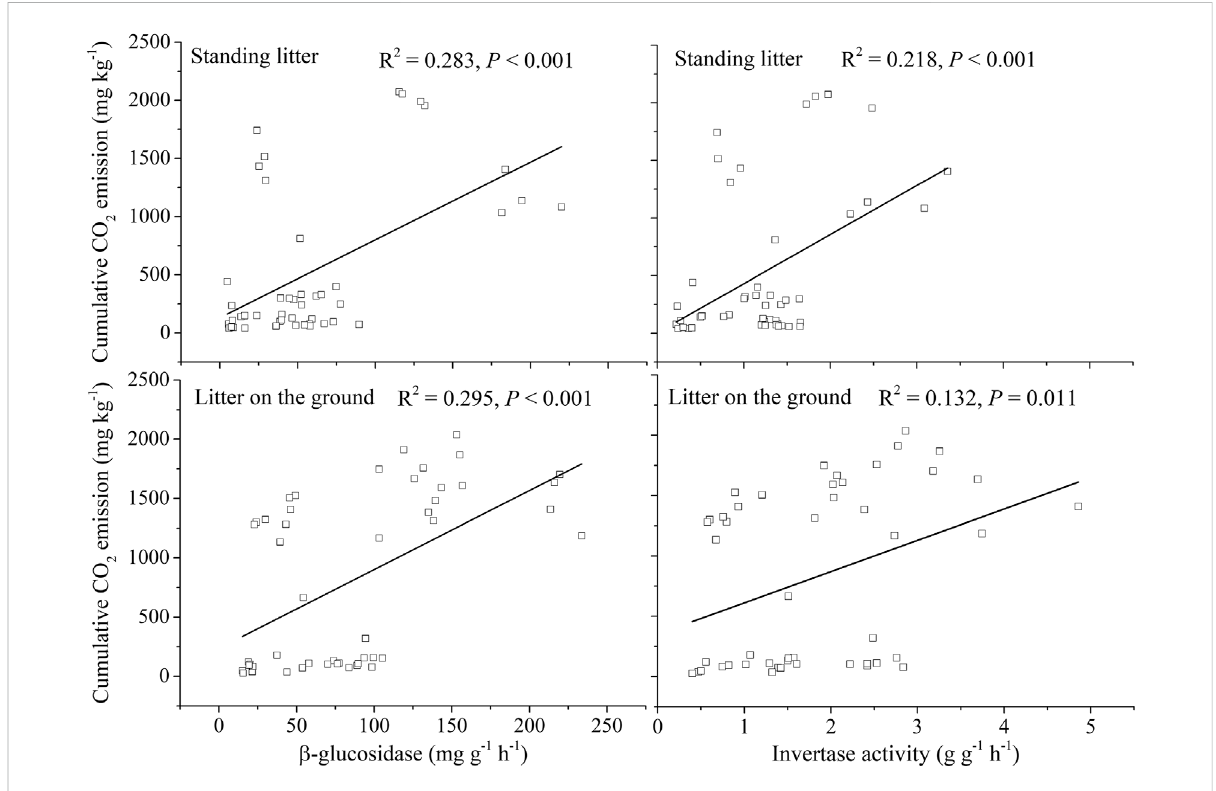
FIGURE 3 Relationships between cumulative CO 2 emissions and enzyme